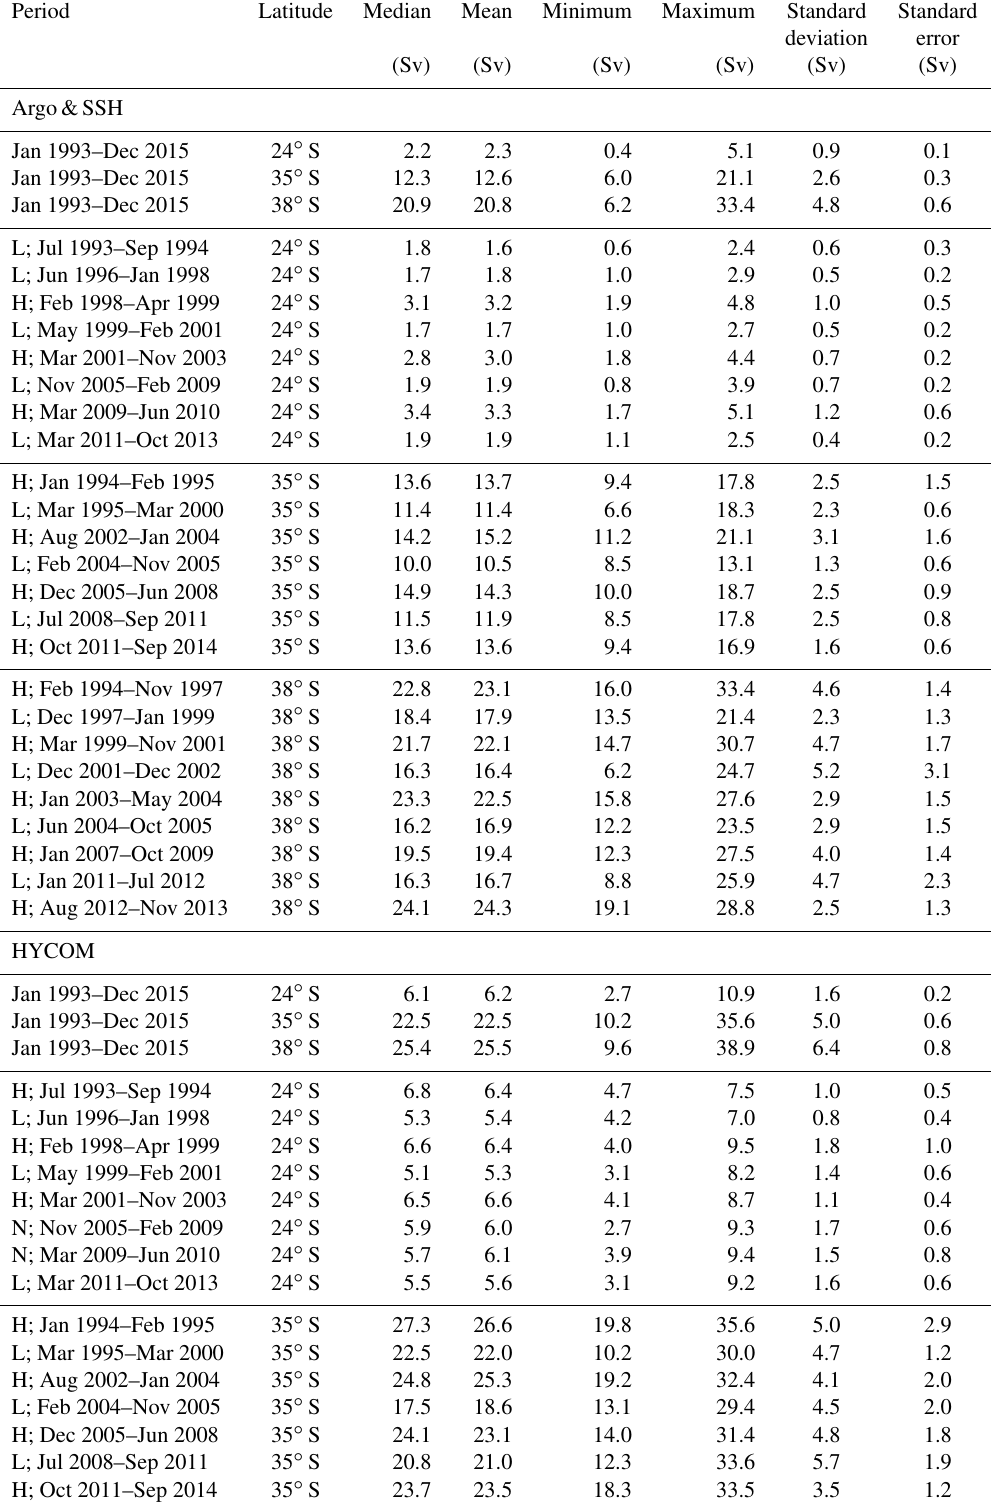
Table 2. Statistics of transports of the Brazil Current from Argo&SSH and HYCOM for the whole time series as well as for periods of relatively low or relatively high transports. Estimates are derived from the time series in Fig. 5. L (H) in the date column indicates low (high) transport while N indicates that a transport is not clearly high or